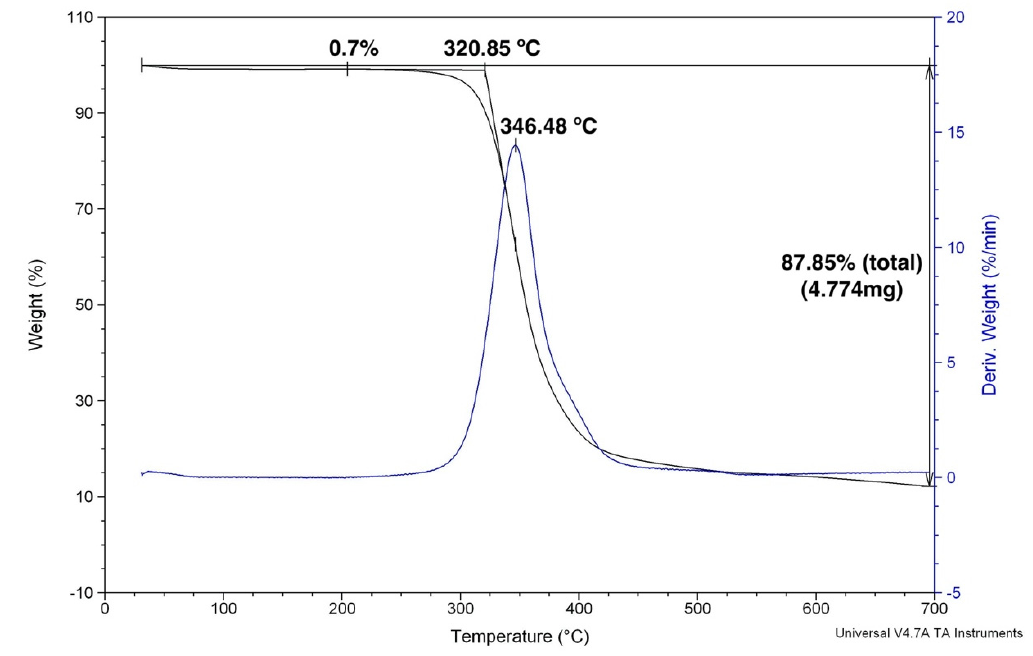
Figure 5. TGA curves for the plain epoxy used as a composite matrix.